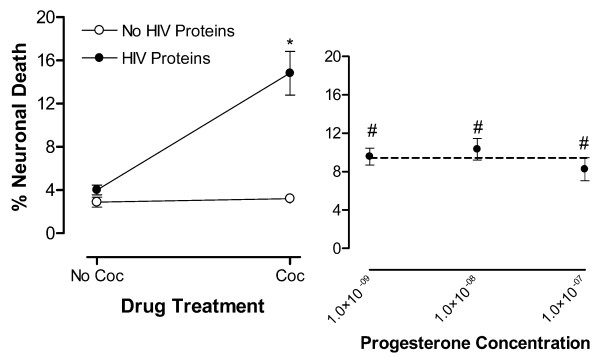
PROG [M] is partially neuroprotective against synergistic neurotoxicity of HIV proteins with cocaine (Coc). Control conditions of incubation with Locke's Buffer vehicle or the HIV proteins or Coc only produced similar neuronal death. (Left Panel) Significant interaction of the HIV proteins with Coc, as illustrated by the lines diverging from parallel, produced toxic synergism (*p < 0.0044). (Right Panel) PROG provided partial neuroprotection against HIV proteins w/ Coc toxic synergism at all concentrations tested (#p < 0.0025) however, the neuroprotection was not concentration dependent.